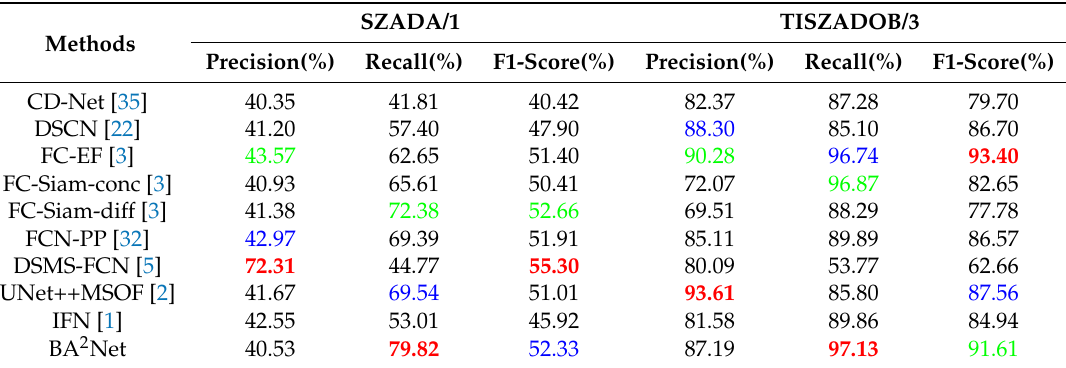
Table 5. Quantitative results on SZTAKI of BA 2 Net and other SOTA